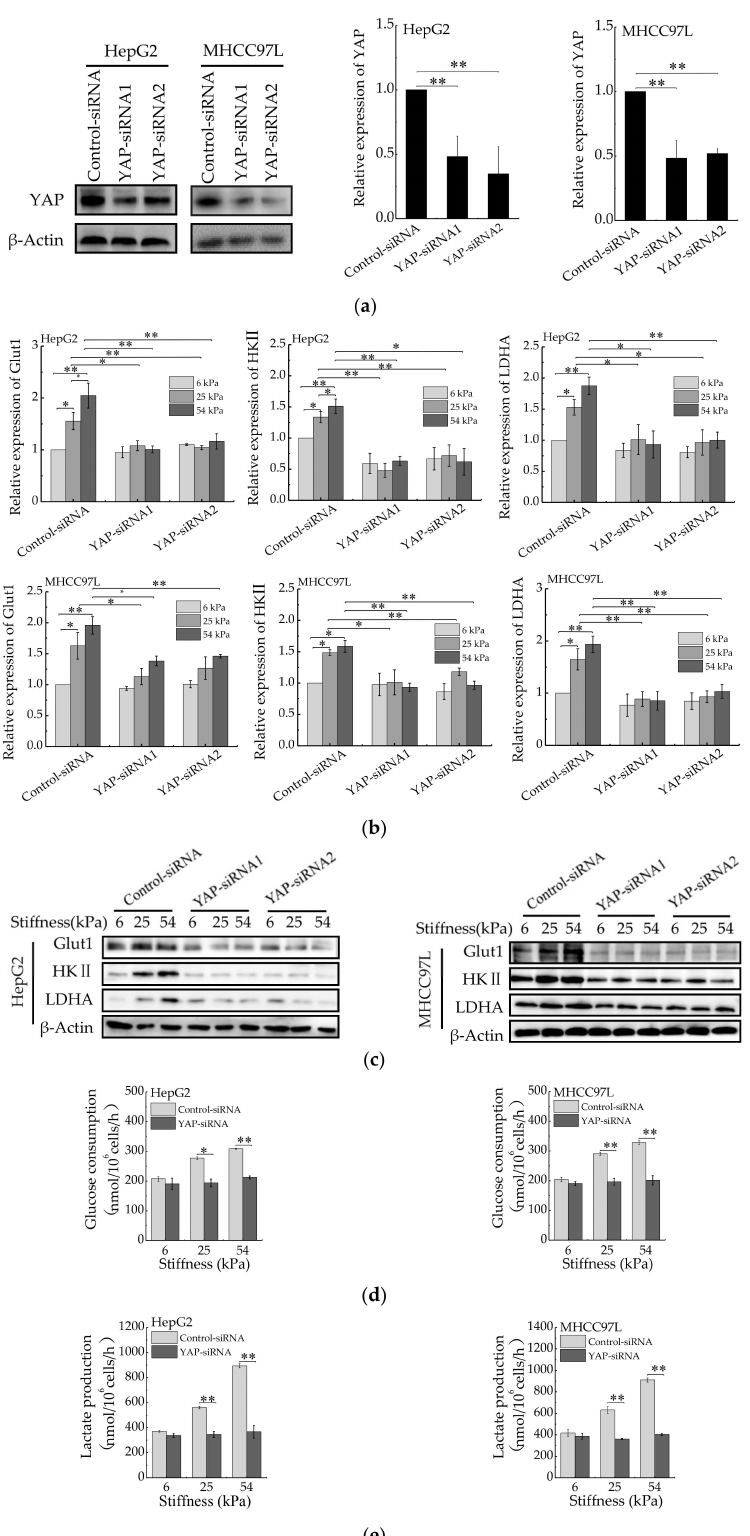
Figure 5. YAP is responsible for ECM sti ff ness-mediated aerobic glycolysis. ( a ) Western blot analysis of YAP expression in HepG2 and MHCC97L cells after YAP knockdown ( n = 3, ** p < 0.01 versus control-siRNA group). ( b ) qRT-PCR analysis of indicated genes mRNA levels in YAP-knockdown HepG2 and MHCC97L cells. ( c ) Western blot analysis of indicated proteins in YAP-knockdown HepG2 and MHCC97L cells. ( d , e ) Measurement of glucose consumption ( d ) and lactate production ( e ) in HepG2 and MHCC97L cells after YAP knockdown ( n = 3, * p < 0.05, ** p <